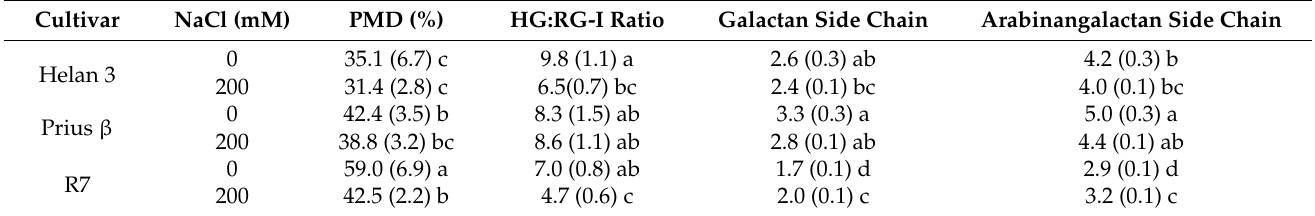
Table 2. Degree of pectin methyl-esterification (PMD) in pectin fractions, HG:RG-I ratio, galactan side-chain length and arabinangalactan side-chain length in Helan 3, Prius β and R7 cultivars under salinity stress. Data are mean ± S.E. ( n = 6).